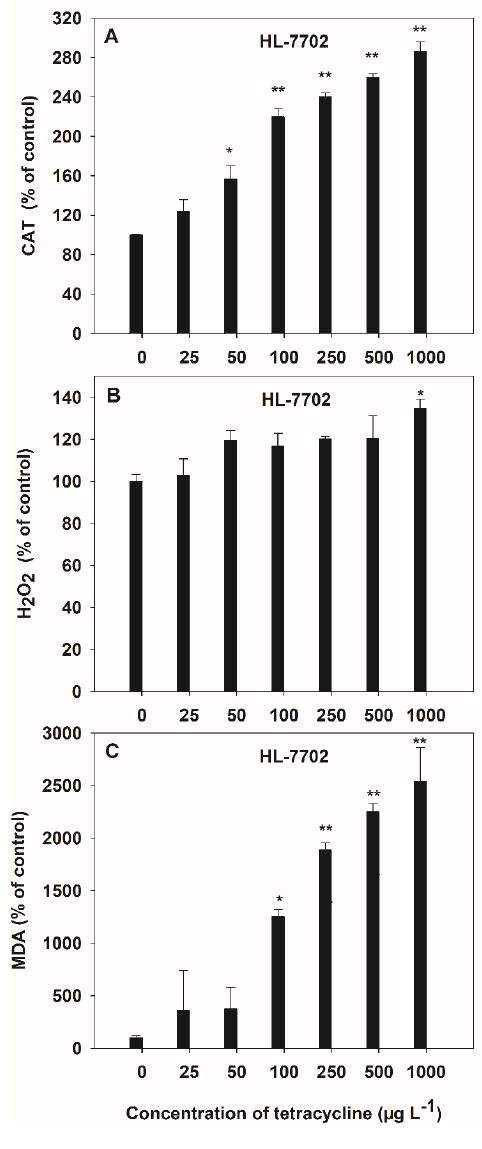
Figure 4. Effect of TC on the activities of CAT ( A ), H 2 O 2 ( B ) and MDA ( C ) contents in HL-7702 cells after 4-h incubation. Data are given as mean ± S.E. ( n = 3); “*” and “**” indicate significant ( p < 0.05) and highly significant ( p < 0.01) differences between controls and treatments, respectively. Significant positive linear correlations ( p < 0.05) were observed between the activities of the antioxidant (CAT) and oxidant (H 2 O 2 and MDA) enzyme, at the TC exposure of 0 – 1000 μg L – 1 (Table 1). The order of correlation coefficients, according to the regression equations, was MDA > H 2 O 2 > CAT for TC, at concentrations from 0 to 1000 μg L – 1 . The TEM microscopic photographs of HL-7702 cells under a control ( 0 μg L – 1 ) and 1000 μg L – 1 stress are shown in Figure 5. After 4 h of culture, TC-induced ultrastructural damage of HL-7702 cells was indicated by changes on the rough endoplasmic reticulum